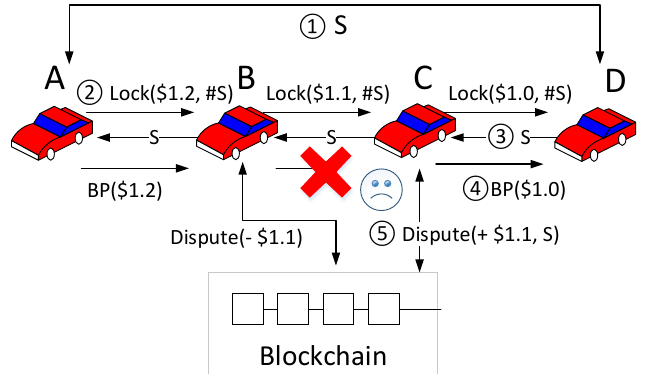
Figure 6. Multi-hop payment example from A to D in the Raiden network. 1. A sends a secret ( S ) to D as a proof of coin receipt. 2. Conditional payment by a locking deposit is conducted sequentially. 3. The secret is returned for the locked payment. 4. Each vehicle unlocks the amount using the final BP after comparing the received secret and a secret hash (# S ). 5. A vehicle creates a dispute if the received secret is incorrect or the deposit is not unlocked in